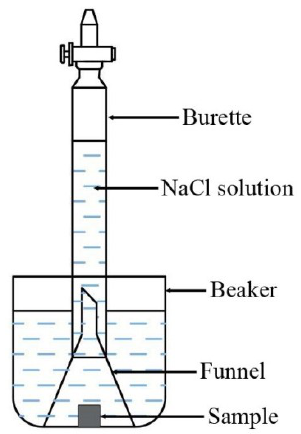
Figure 1. Schematic of corrosion test equipment.